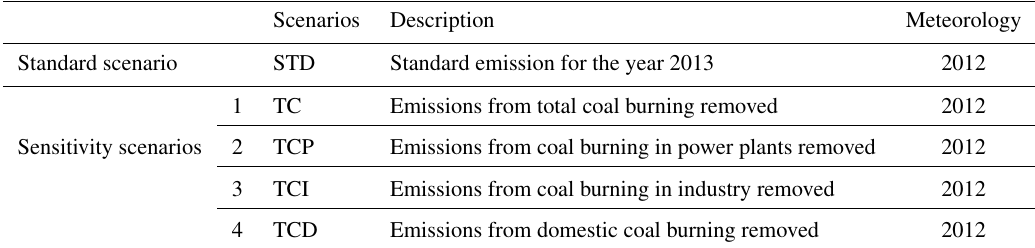
Table 2. Summary for simulation